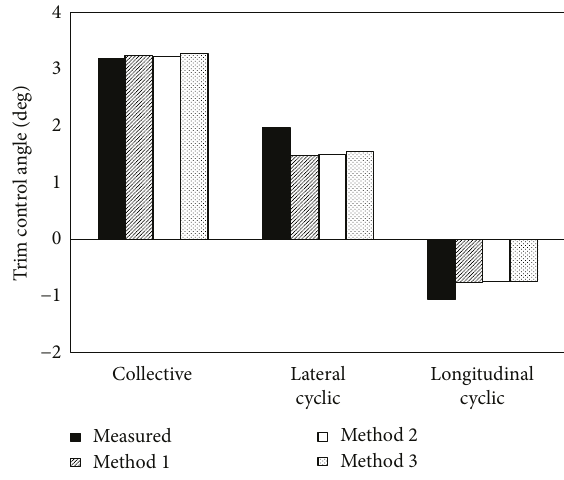
Figure 8: Comparison of trim control